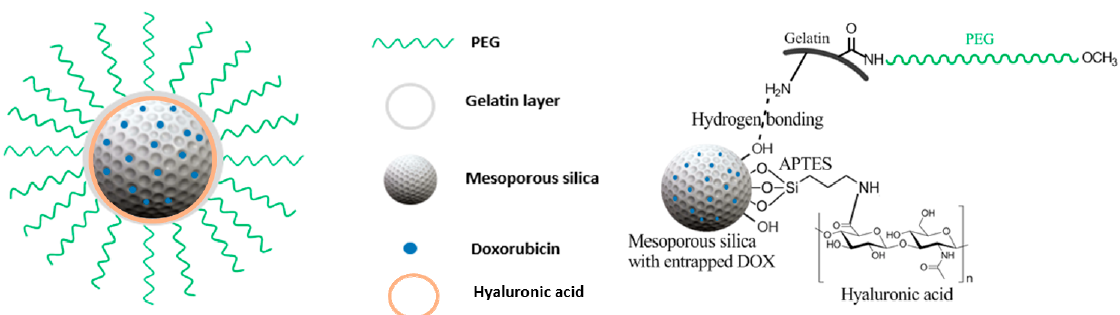
Figure 13. Doxorubicin/mesoporous silica nanoparticles (MSN)-Gelatin-PEG nanoparticulate design.